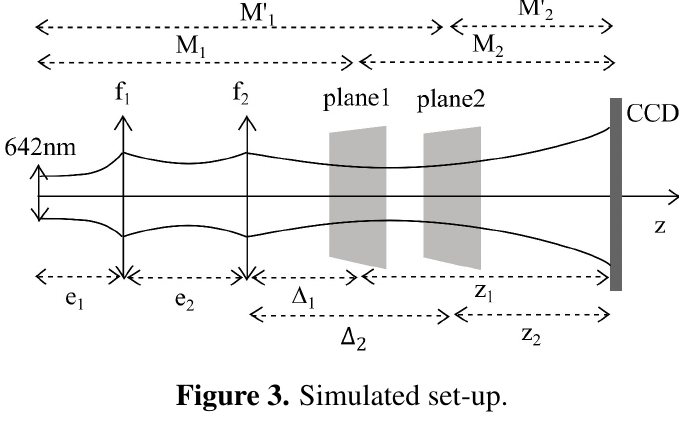
Figure 3. Simulated